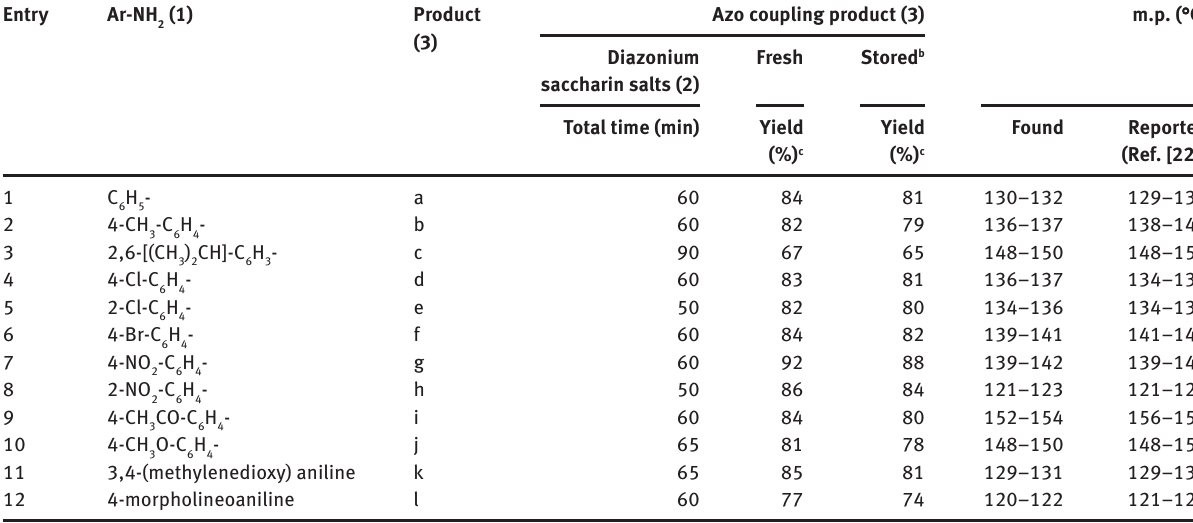
Table 1: Telescopic azo coupling reaction of the aniline derivatives with 4-hydroxybenzaldehyde at ice bath via modified Knoevenagel’s method.